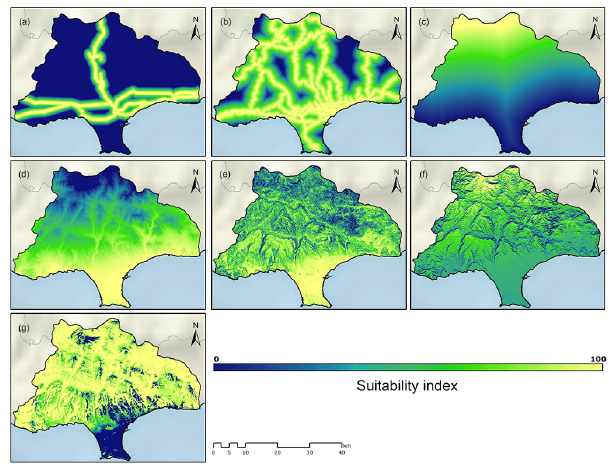
Figure 4. Standardized evaluation layers (a) electricity grid, (b) road network, (c) land value, (d) elevation, (e) slope, (f) solar energy, and (g) viewshed from primary roads. Table 2. Evaluation criteria of the case